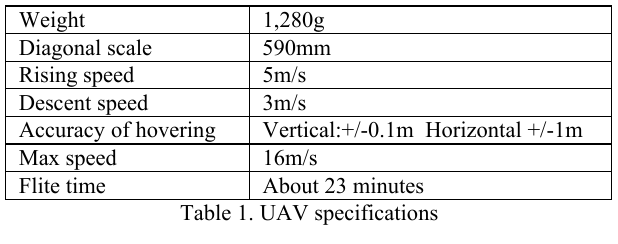
Table 1. UAV specifications